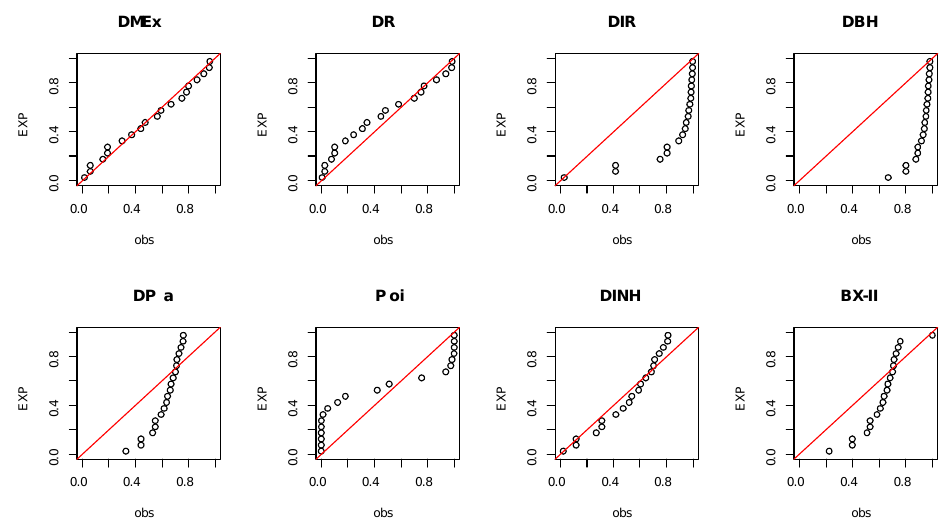
Figure 13. P-P visualization plots for LR data. Figure 13 . P-P visualization plots for LR data.